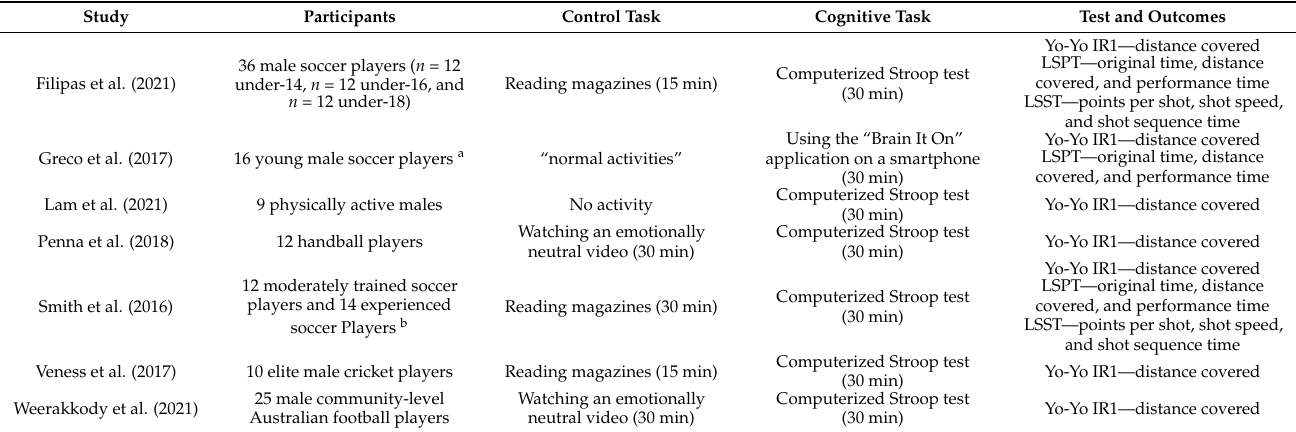
Table 2. Summary of the studies included in the review.